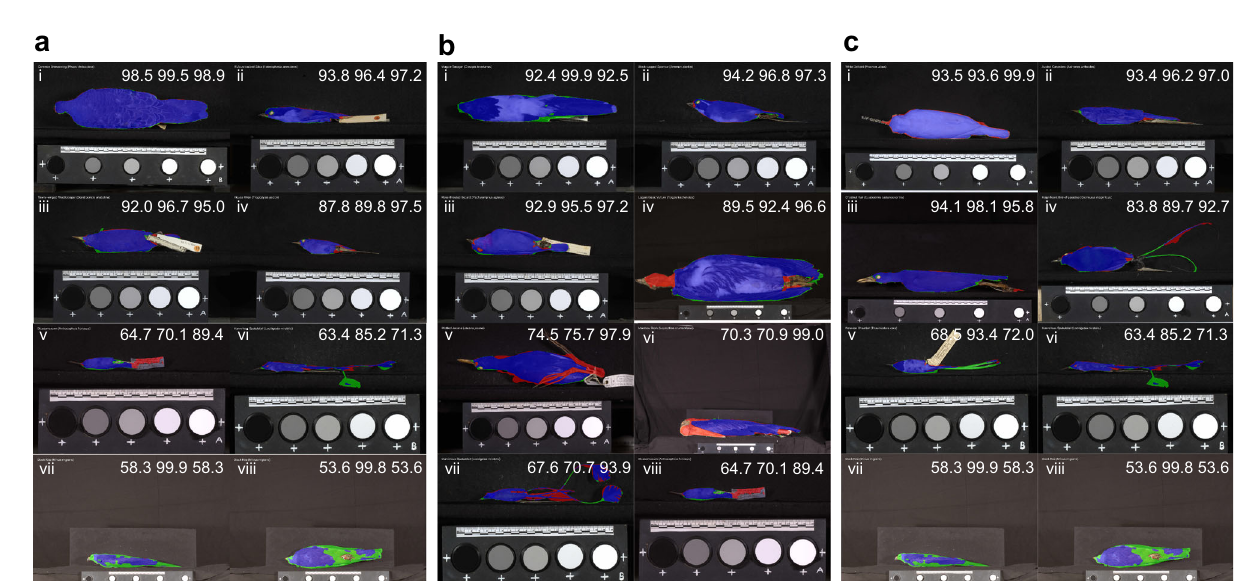
Fig.2|ExamplesofimagessegmentedbyDeepLabv3+. Imagesofthebest,50th, 75th and 95th percentile (ranked by metrics from high to low; from i to iv) and 4 worst predictions(from v to viii) based on a IOU, b precision and c recall. The IOU, precisionandrecall(fromlefttoright)aredisplayedonthetoprightcornerofeach